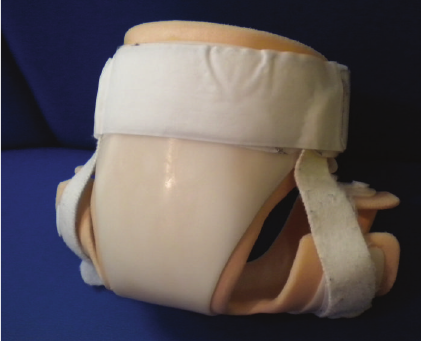
Figure 3: Brace, view from behind.